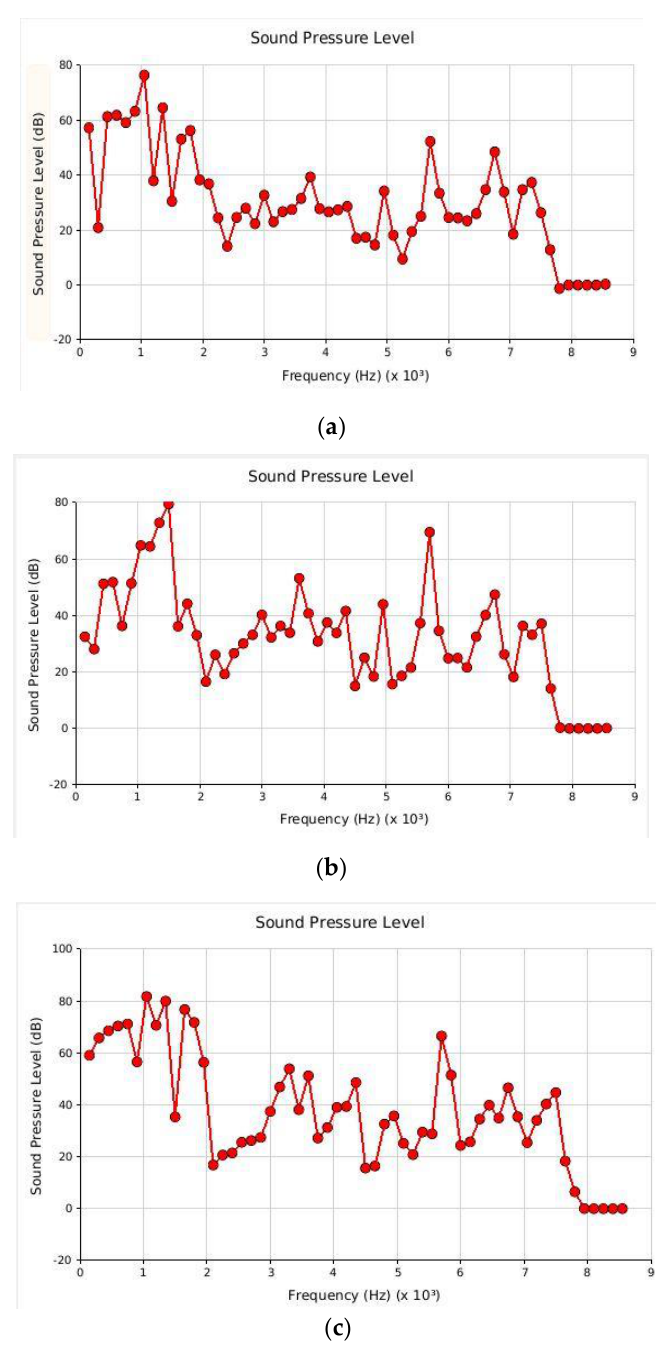
Figure 21. Stator system electromagnetic noise at 3000 rpm. ( a ) Electromagnetic noise at no load. ( b ) Electromagnetic noise at rated load. ( c ) Electromagnetic noise at peak load.